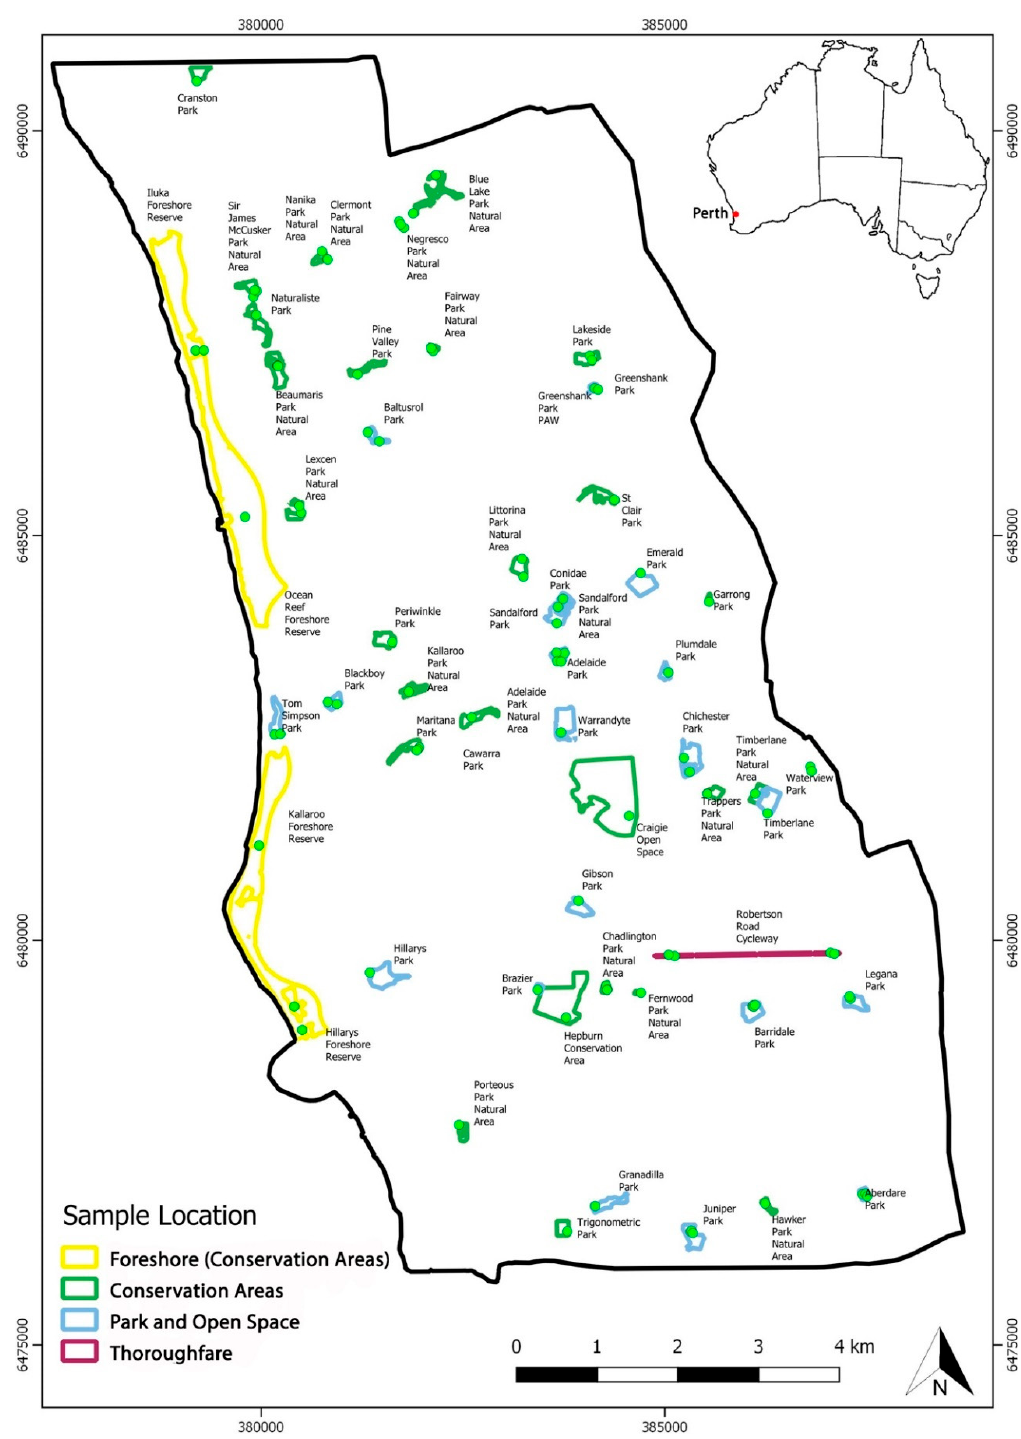
Figure 1. Location of the 91 parks in the City of Joondalup, Western Australia, assessed by remote sensing. Overall, 236 discrete sampling sites (green dots) were selected among these parks in areas where declining vegetation was observed, and soil and roots were sampled for baiting and metabarcoding. A map of Australia is inserted into the top right corner showing the location of Perth.